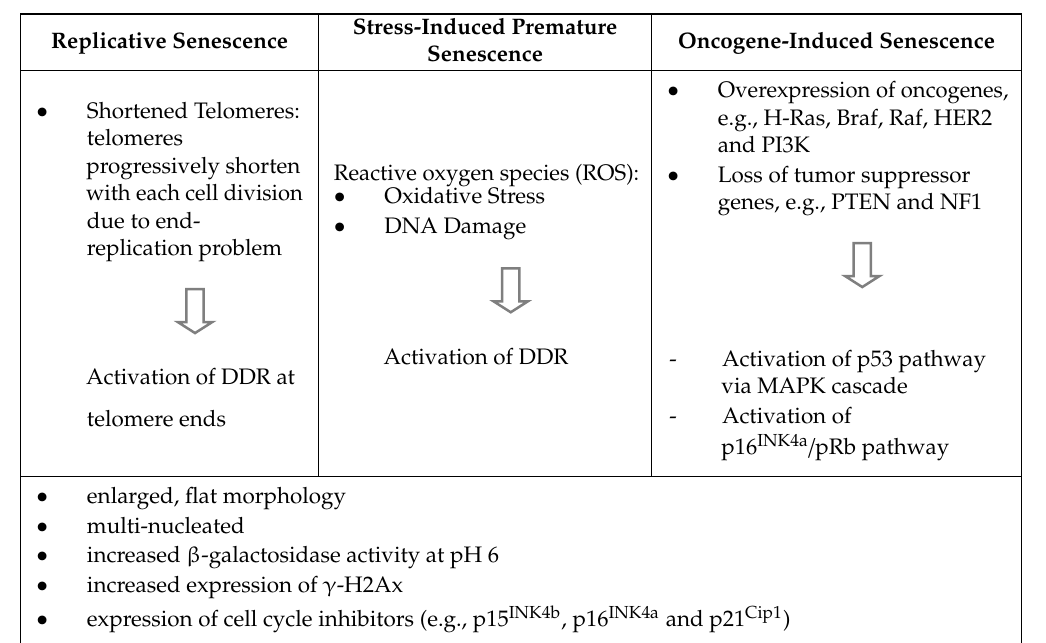
Table 1. Senescence markers and molecular players in different types of senescence.